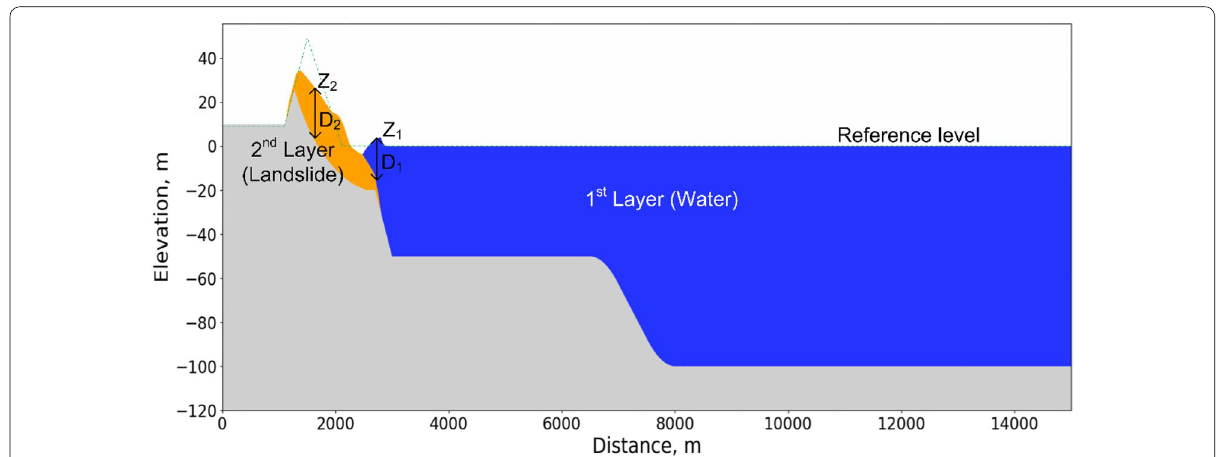
Fig. 6 Two-layer conceptual schematic of the parameters for modeling the subaerial-submarine